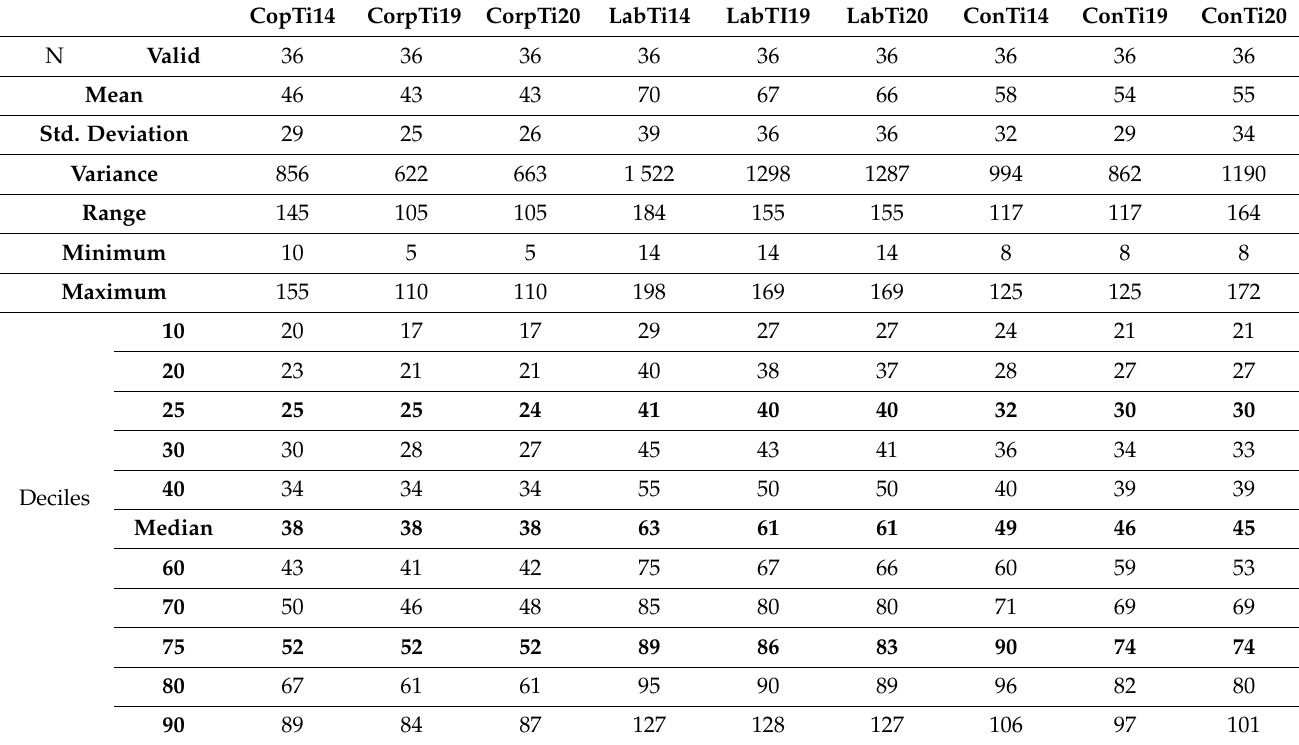
Table 5. Descriptive statistical analysis of the variables used for the composite indicator